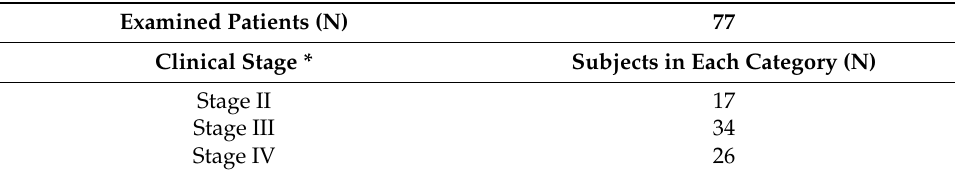
Table 1. Disease stage of the examined RTT population.